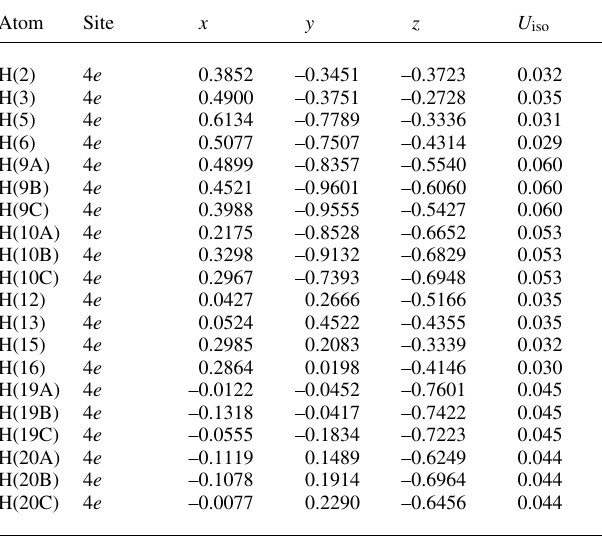
Table 2. Atomic coordinates and displacement parameters (in Å 2 )